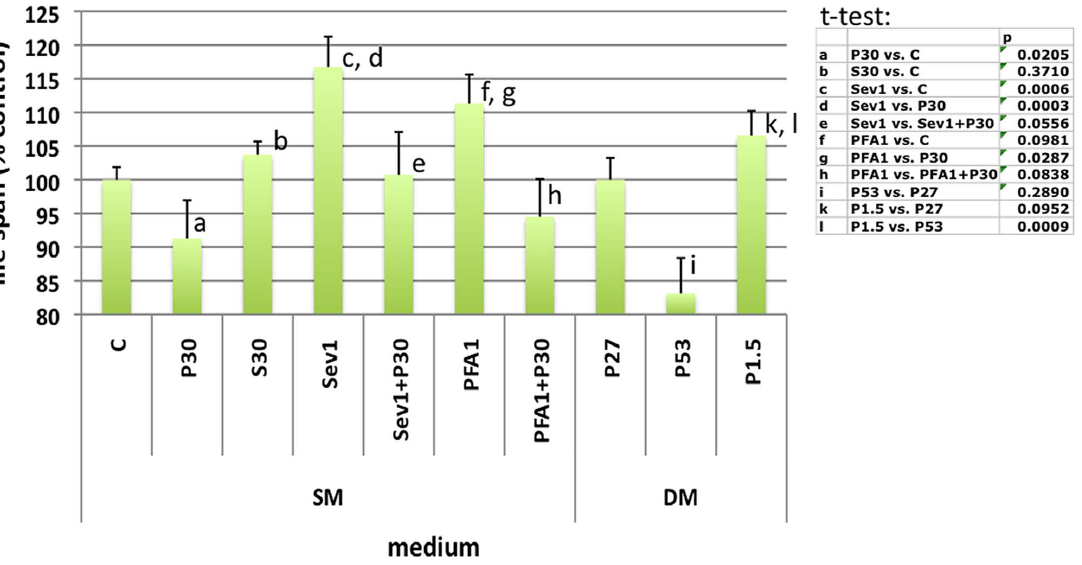
Figure 2. Phosphate supplementation or inhibitors of phosphate uptake influences adult life span. Median life span of adult y w males cultured on standard medium (SM): Control (C, n=550), 30 mM sodium phosphate (P30, n=465), 30 mM sodium sulfate (S30, n=245), 1% sevelamer (Sev1, n=207), 1 mM phosphonoformic acid (PFA1, n=130), and the combinations: Sev1 + P30 (n=115), PFA1 + P30 (n=137), or defined medium (DM) supplemented with 1.5, 27, or 53 mM sodium phosphate (P1.5, n=202; P27, n=200; P53, n=194). P , 0.005 was used to test for multiple comparisons between eleven treatments.